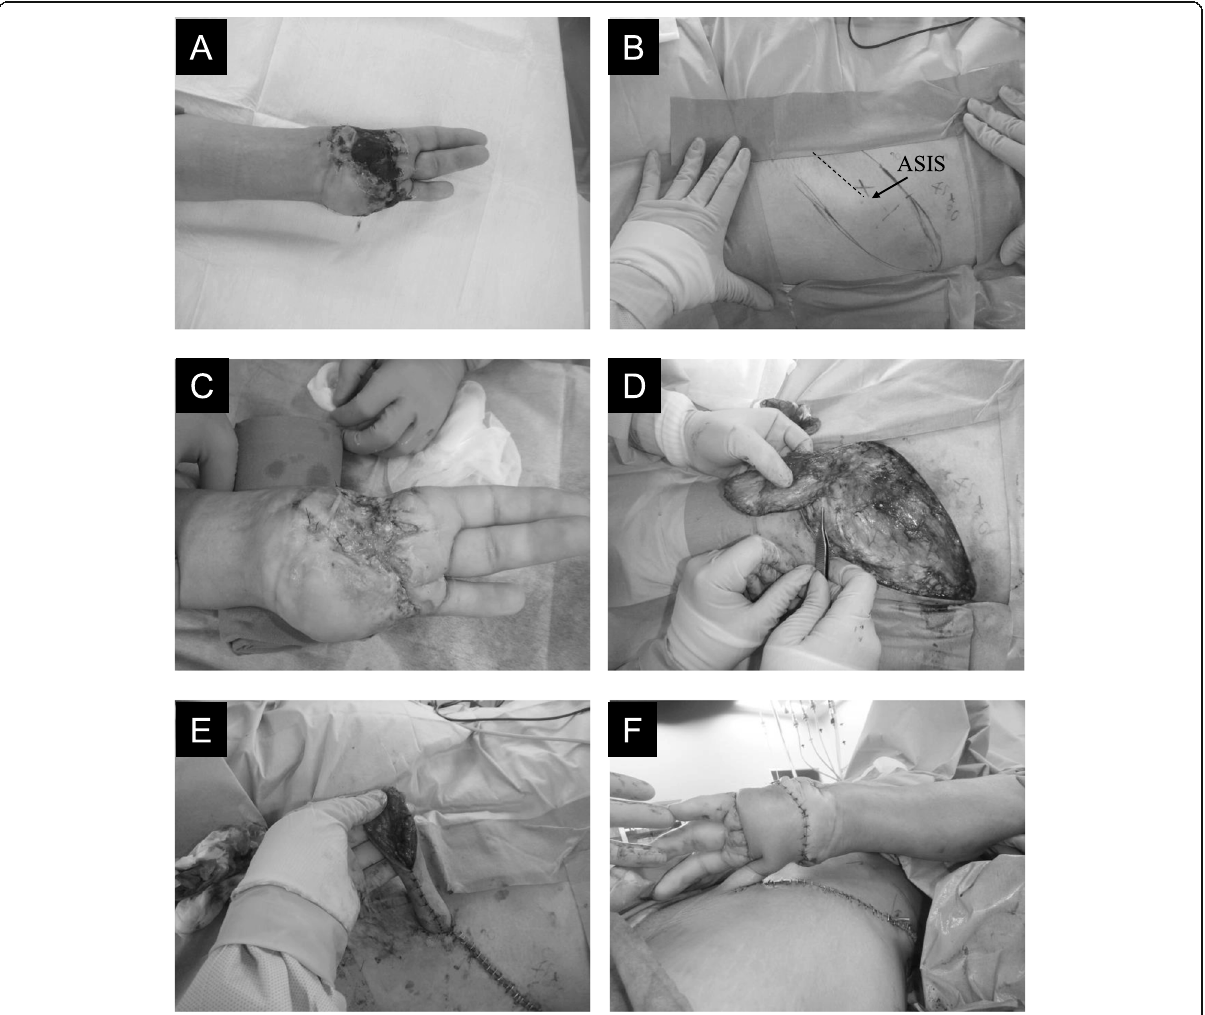
Fig. 1 a Injured left hand with necrosis. Both the thumb and the index finger were missing. b The donor site of the pedicle groin flap in the left inguinal region. The dotted line between the anterior superior iliac spine (ASIS) and the femoral artery 2 – 2.5 cm below the inguinal ligament is drawn (axial line of the flap). c Debridement of the left hand. d Construction of the flap. e Tubed pedicle. f The flap sutured in